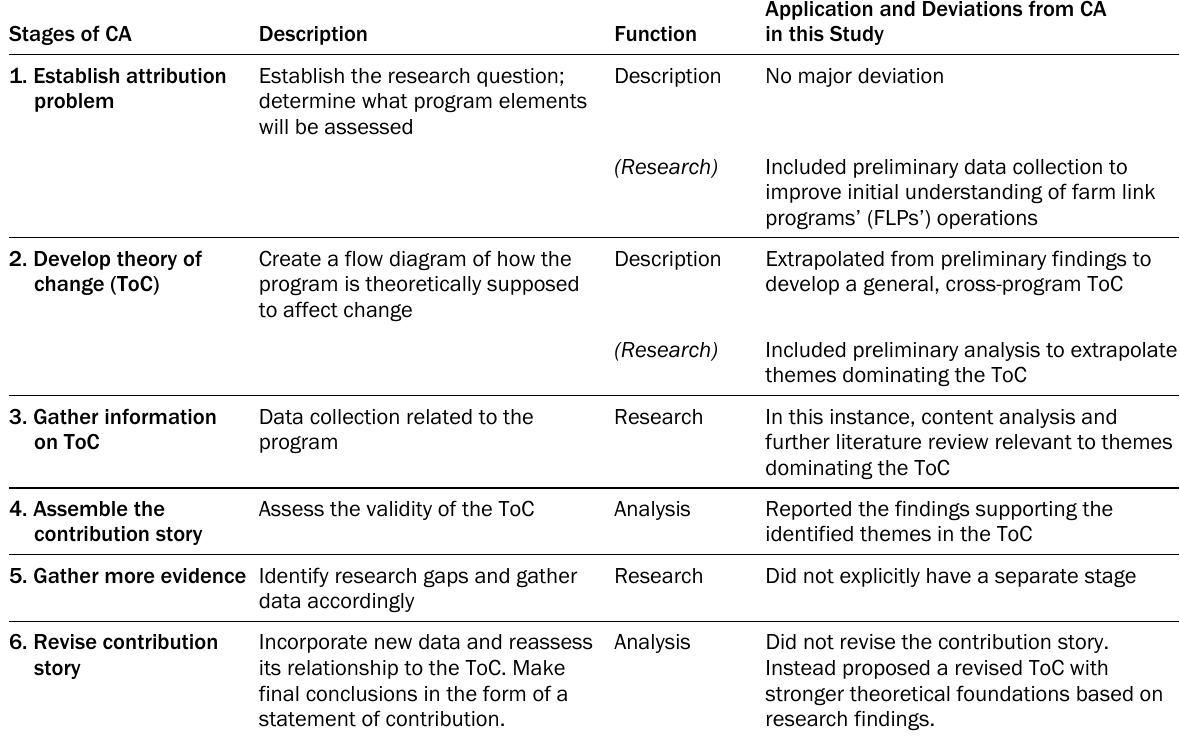
Table 1. Stages of Contribution Analysis (CA) and Applications in This Study of Farm Link Programs Stages of